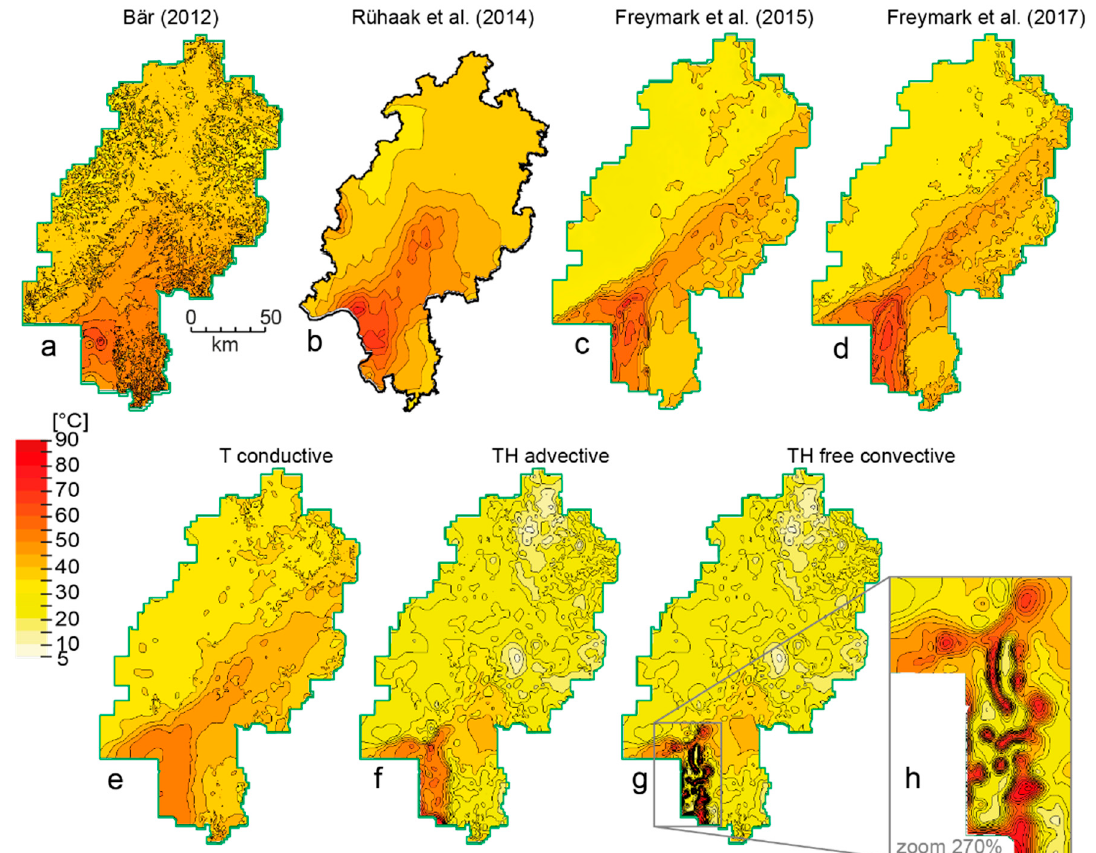
Figure 13. Simulated temperature distribution at 1 km depth with yellow cold to red hot temperatures. Previous modelling studies chronologically by ( a ) Bär [21], ( b ) Rühaak et al. [23], ( c ) Freymark et al. [19] and ( d ) Freymark et al. [8] and simulation results of this study considering ( e ) conductive, ( f ) conductive and advective and ( g ) conductive, advective and free convective heat transport. ( h ) illustrates a zoom into the northern part of the Upper Rhine Graben (grey frame in Figure g) to better visualize the single thermal anomalies.